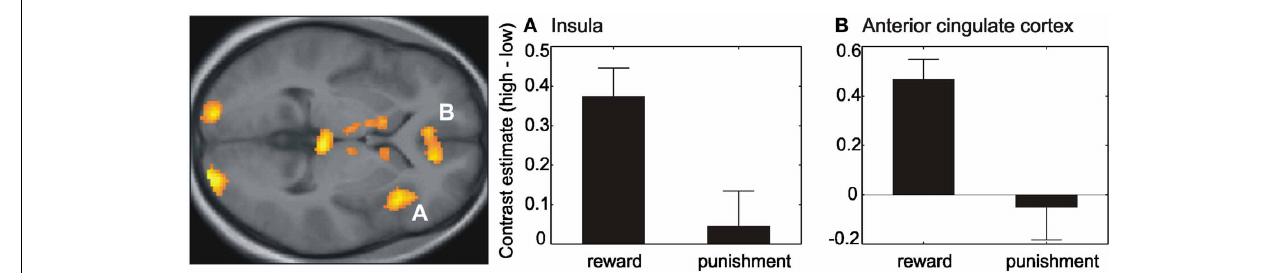
FIGURE 4 | Effect of reinforcement-value. Contrast estimates (high–low) within the right anterior insula (A) and anterior cingulate cortex (B) revealed a difference between the high and low reinforcement within the reward session but no difference within the punishment session.